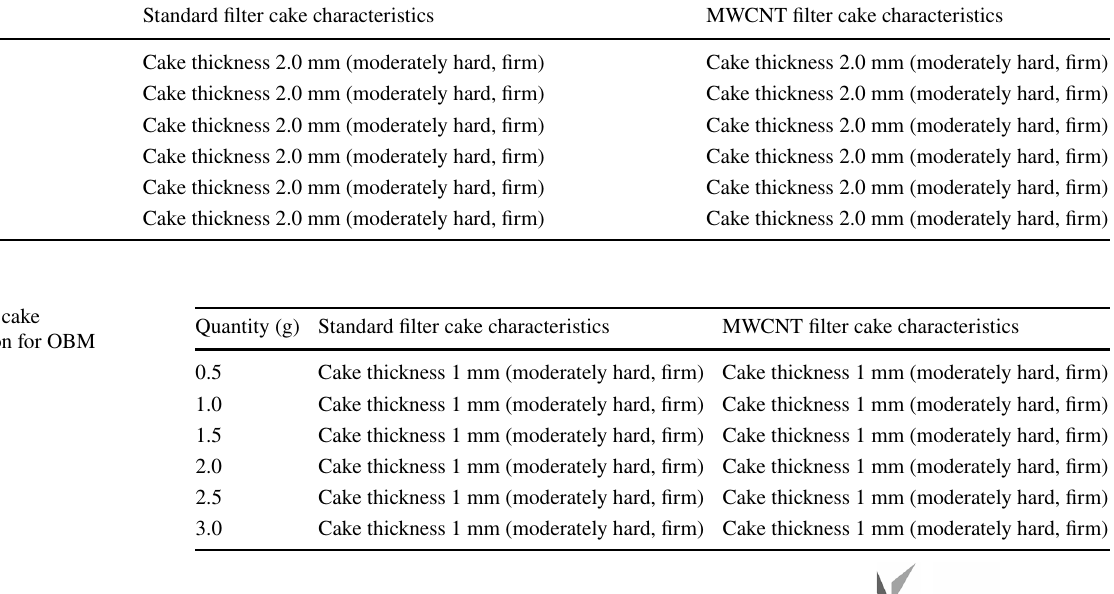
Table 4 Filter cake characterization for WBM Quantity (g)